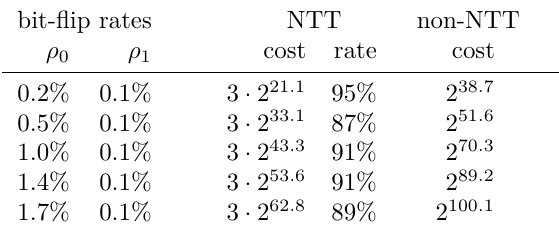
ZJGS17, Saa17, SPL + 17, DTGW17, SAB + 17, LDK + 17, CLP17], make use of a